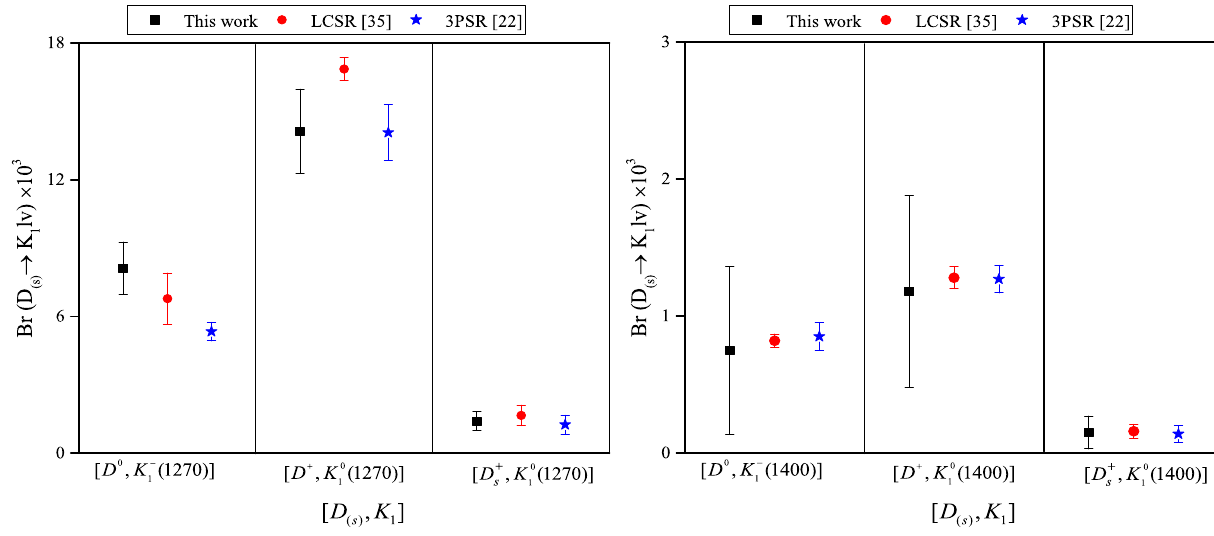
Fig. 7 The θ K dependence of differential branching ratios of the semileptonic D ( s ) → K 1 ( 1270 )(cid:2)ν and D ( s ) → K 1 ( 1400 )(cid:2)ν transitions with their uncertainly bands